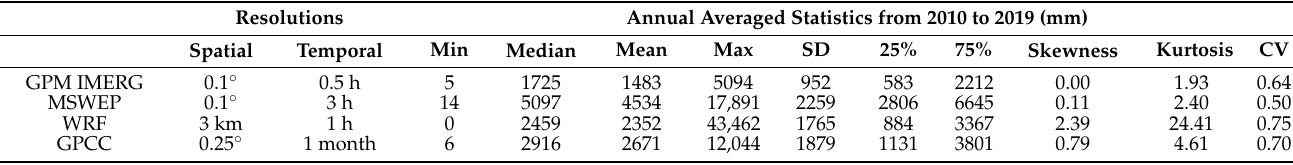
Table 1. List of precipitation products analyzed in this study and their averaged annual precipitation statistics from 2010 to